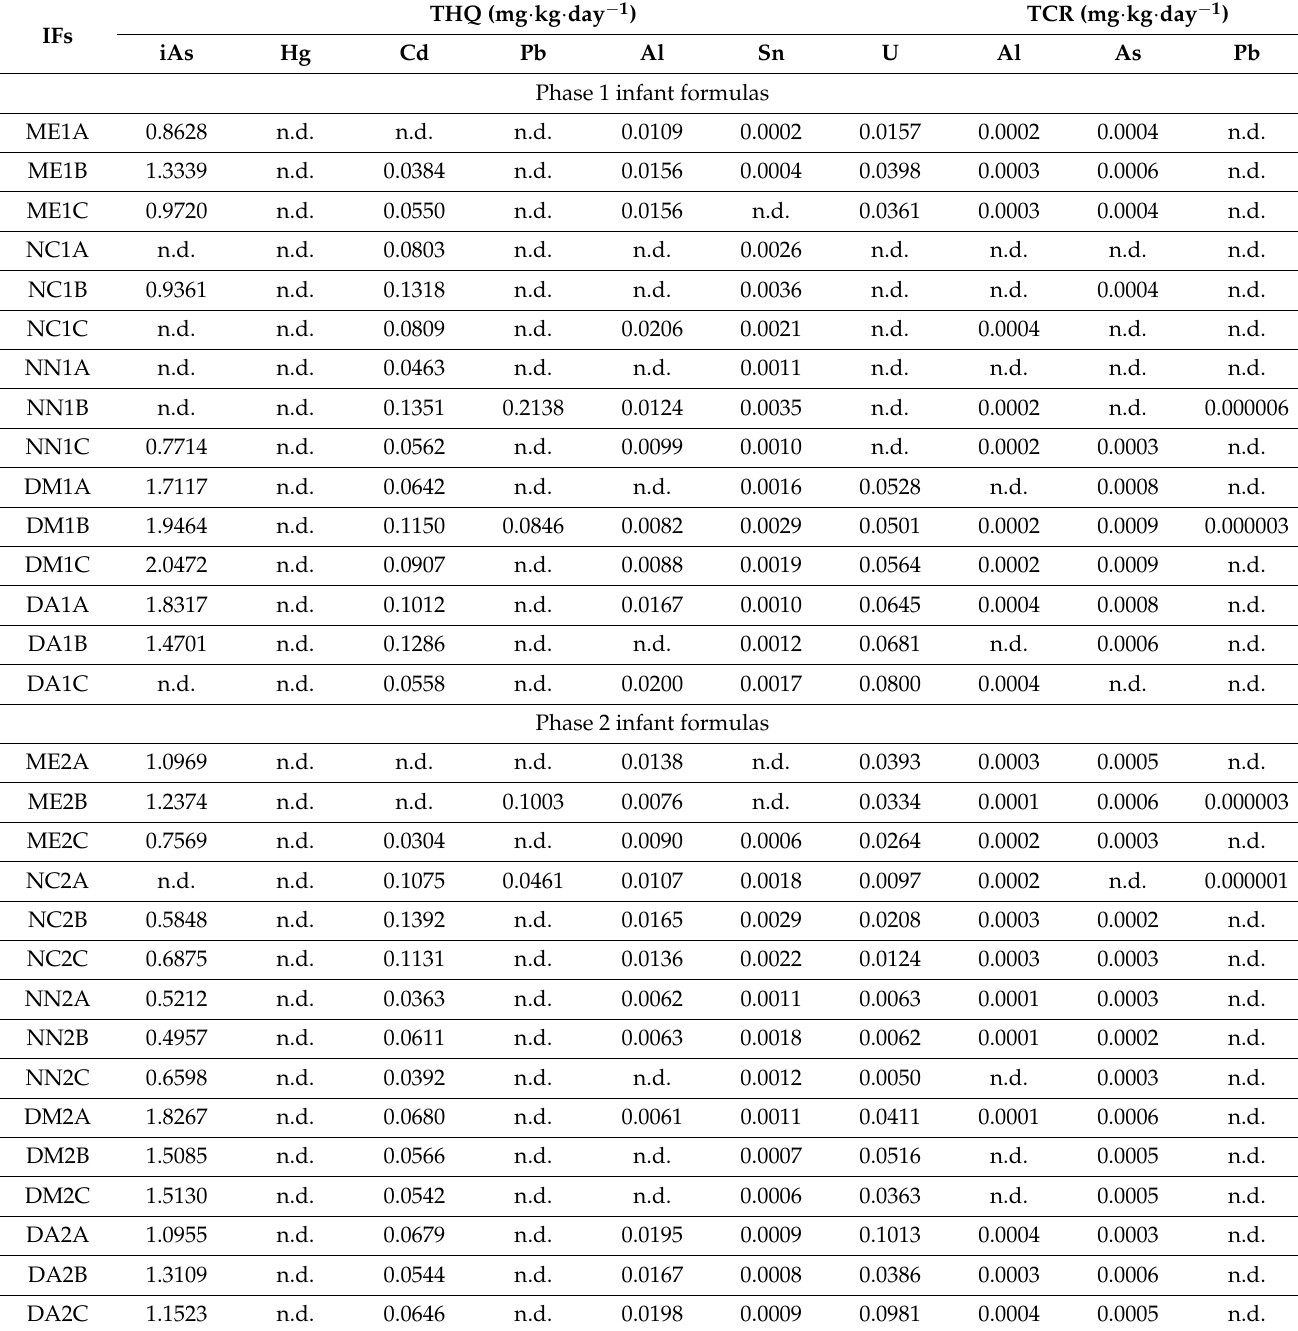
Table 5. Target hazard quotient (THQ) to the toxic metals and metalloids, and the target cancer risk (TCR) of Al, As, and Pb estimated in batches of phase 1 and phase 2 infant formulas.